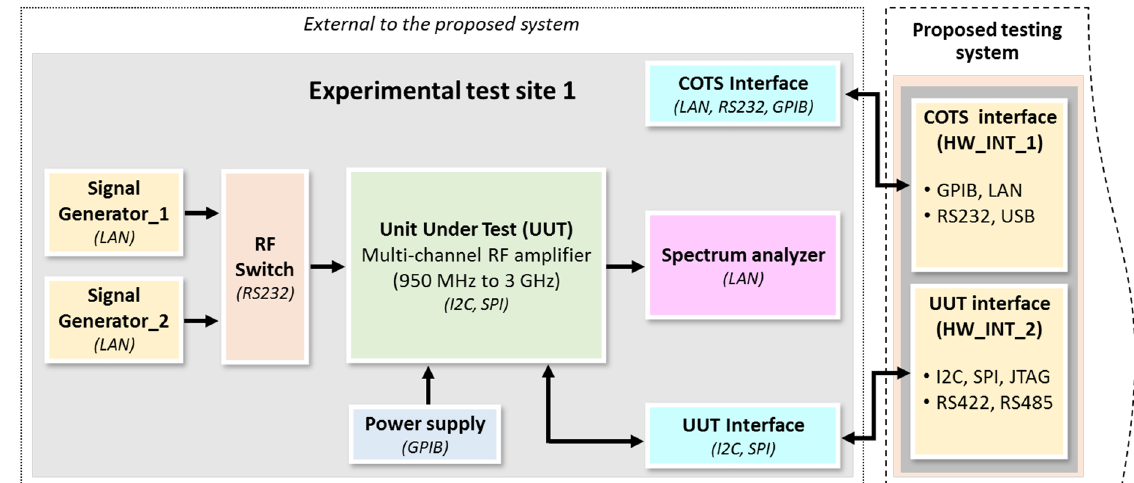
Figure 8. Experimental test site 1 setup.